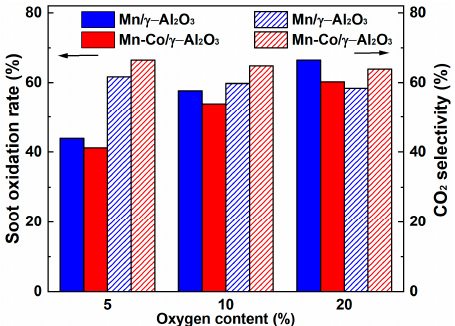
Figure 7. Effect of oxygen content on plasma–catalytic soot oxidation at 30th min over Mn-Co/ γ - Al 2 O 3 and Mn/ γ -Al 2 O 3 catalysts (discharge power: 14 W, reaction temperature: 150 °C, reaction time: 30 min and gas flow rate: 500 mL·min − 1 ).